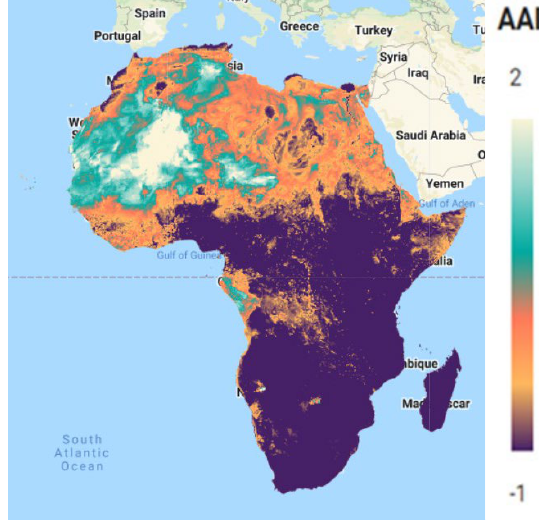
Fig. 7. Aerosol movement from the 28 th – 30 th of June